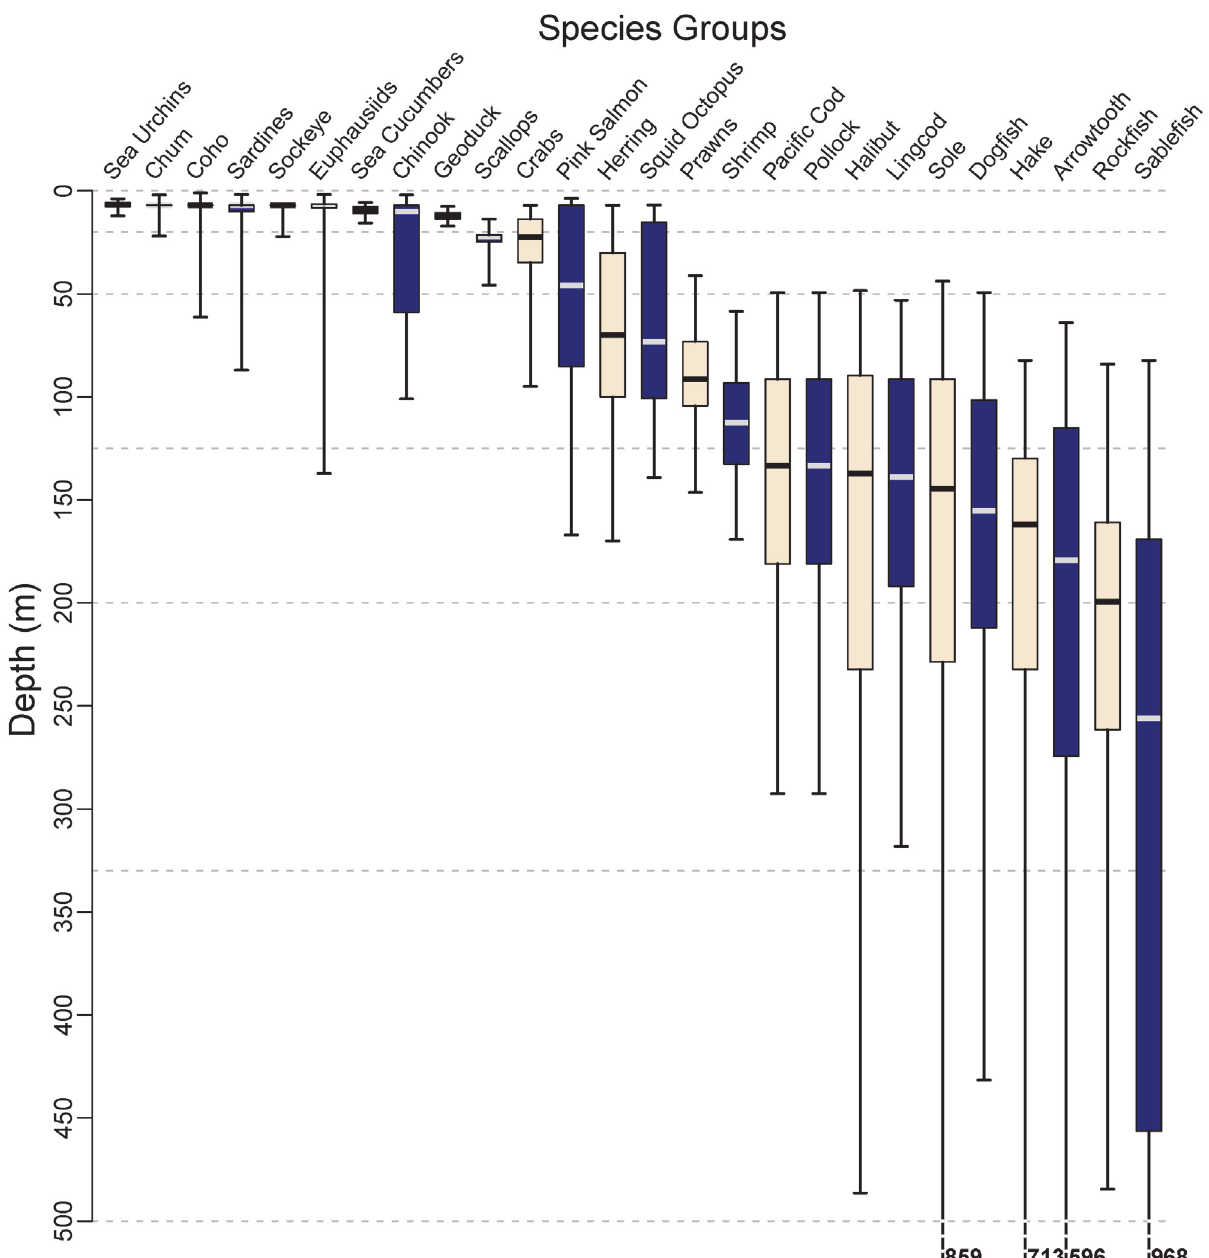
Fig 3. Depth-of-capture, expressed as quantile box plots of depth (m), from fisheries and survey data (where available) for species groups identified in Fig. 4. For each quantile box, the upper whisker, box top, box delimiter (horizontal line), box bottom and lower whisker correspond to the 0.025, 0.25, 0.5, 0.75, and 0.975 quantiles, respectively. Depth quantiles that lie deeper than the figure limit are indicated along the bottom. Horizontal dashed lines correspond to depth zones in Fig. 2. See Methods for data sources. Data and R code for this figure are provided in Supporting Information (S1 Data and S3 Code,